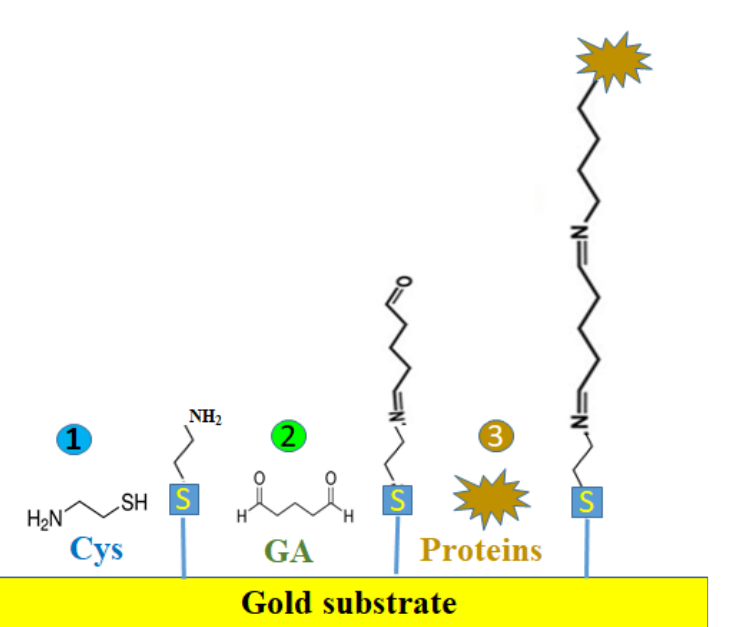
Figure 2. Stepwise immobilization of proteins on the gold substrate using relatively inexpensive cysteamine (Cys)/glutaraldehyde (GA) reagents. Three (bio)functionalization steps are required: (1) incubation with aqueous/ethanol Cys solution; (2) incubation with aqueous GA solution; and (3) incubation with proteins from various human biological fluids such as whole blood, serum, saliva, and urine.